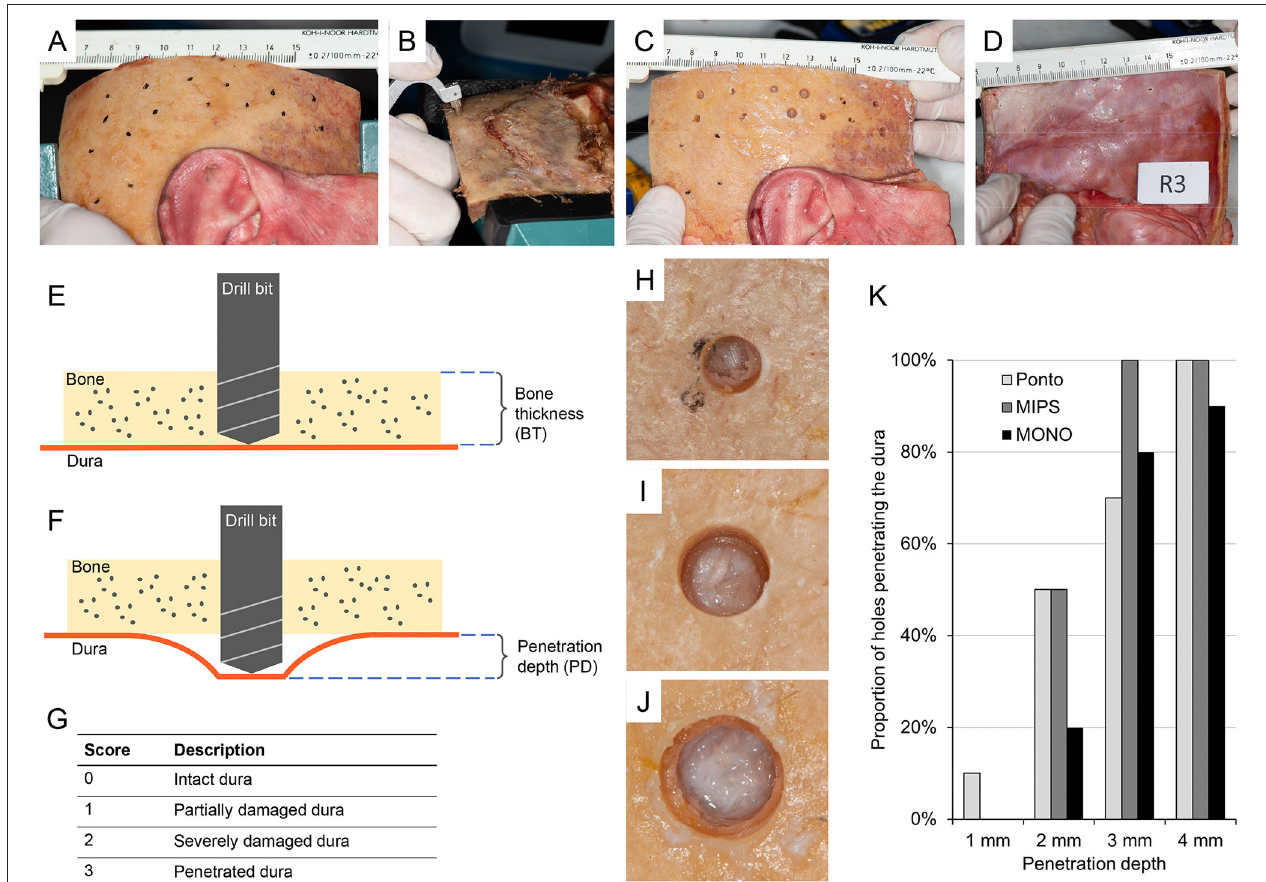
FIGURE 3 | (A) Temporal bone sample (item R3) with removed soft tissue and sites marked according to the randomization scheme. (B) The bone thickness (BT) at the sites determined using a caliper. (C) Photograph of a temporal bone sample (item R3) after drilling sequence. (D) Photograph of the dura of the same temporal bone sample (item R3) after drilling was performed. (E) Illustration of the preparation of holes in the temporal bone. (F) Illustration of penetration depth. The drill bit penetrates beyond the base of the skull bone to different depths. (G) Scoring scale of the impact of the drill on the dural tissue. (H) Example of a hole using the round burr (Ponto) with a score of 2 indicating severely damaged dura. (I) Example of a hole using a guide drill (MIPS) with a score of 1 indicating partially damaged dura. (J) Example of a hole using a MONO drill with a score of 0 indicating intact dura. (K) Proportion of holes penetrating the dura for the different drill systems (Ponto,